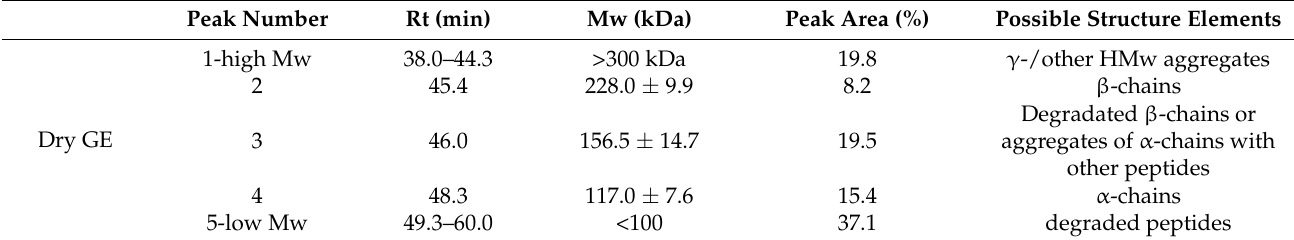
Table 2. Molecular weight of gelatin from tuna skin of the distributions shown in Figure 2 (mean ± standard deviation; n = 2). Rt: retention time; Mw: weight average molecular weight. Peak area (%) corresponds to the refractive index